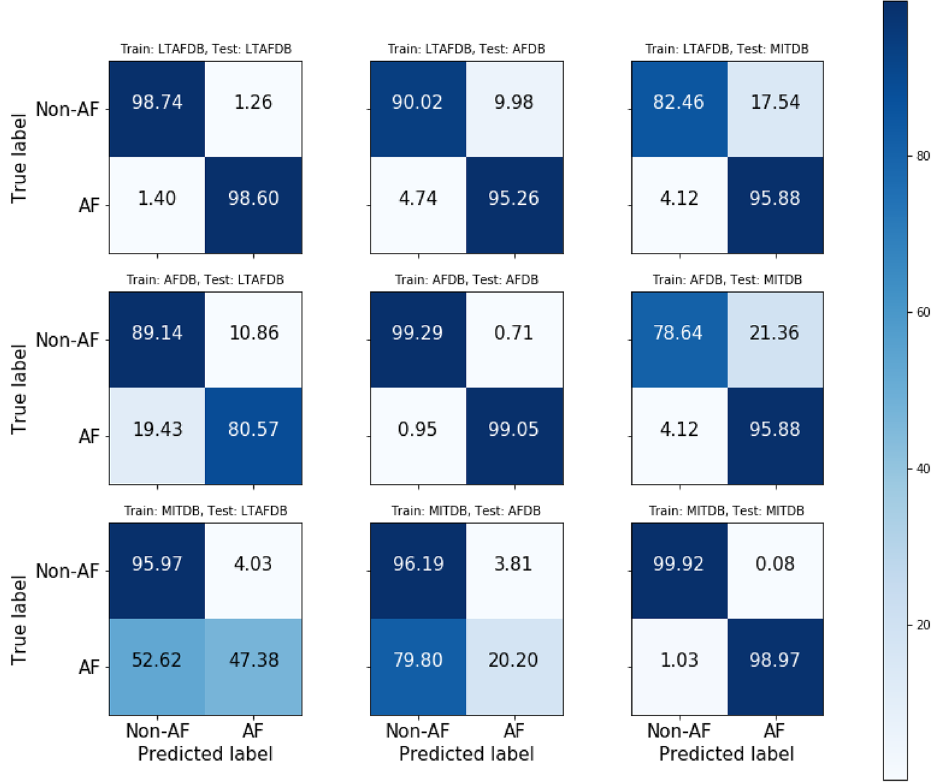
Figure 3. Confusion matrix of the Resnet 50 model for estimating data dependency. The confusion matrices in the first row are results of the trained models on LTAFDB. The second row shows results of the trained models on AFDB and the third row shows results of the trained models on MITDB. The confusion matrices in the first column are results evaluated by LTAFDB. Also, the second column show results evaluated by AFDB and the third column show results evaluated by